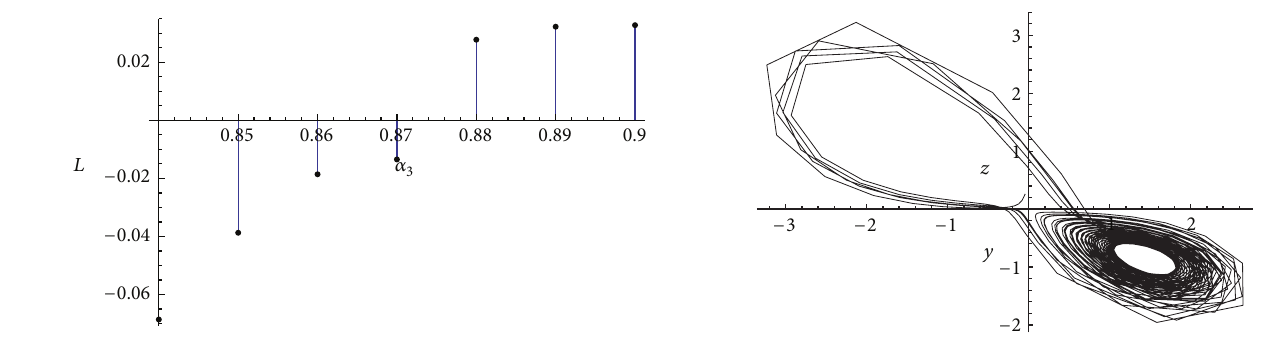
Figure 8: Lyapunov exponent- 𝛼 3 .